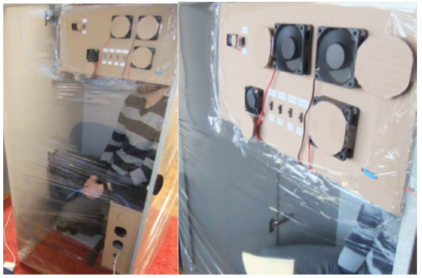
Figure 3. Left 2 fans ON~250 lpm Right 4 fans ON~1250